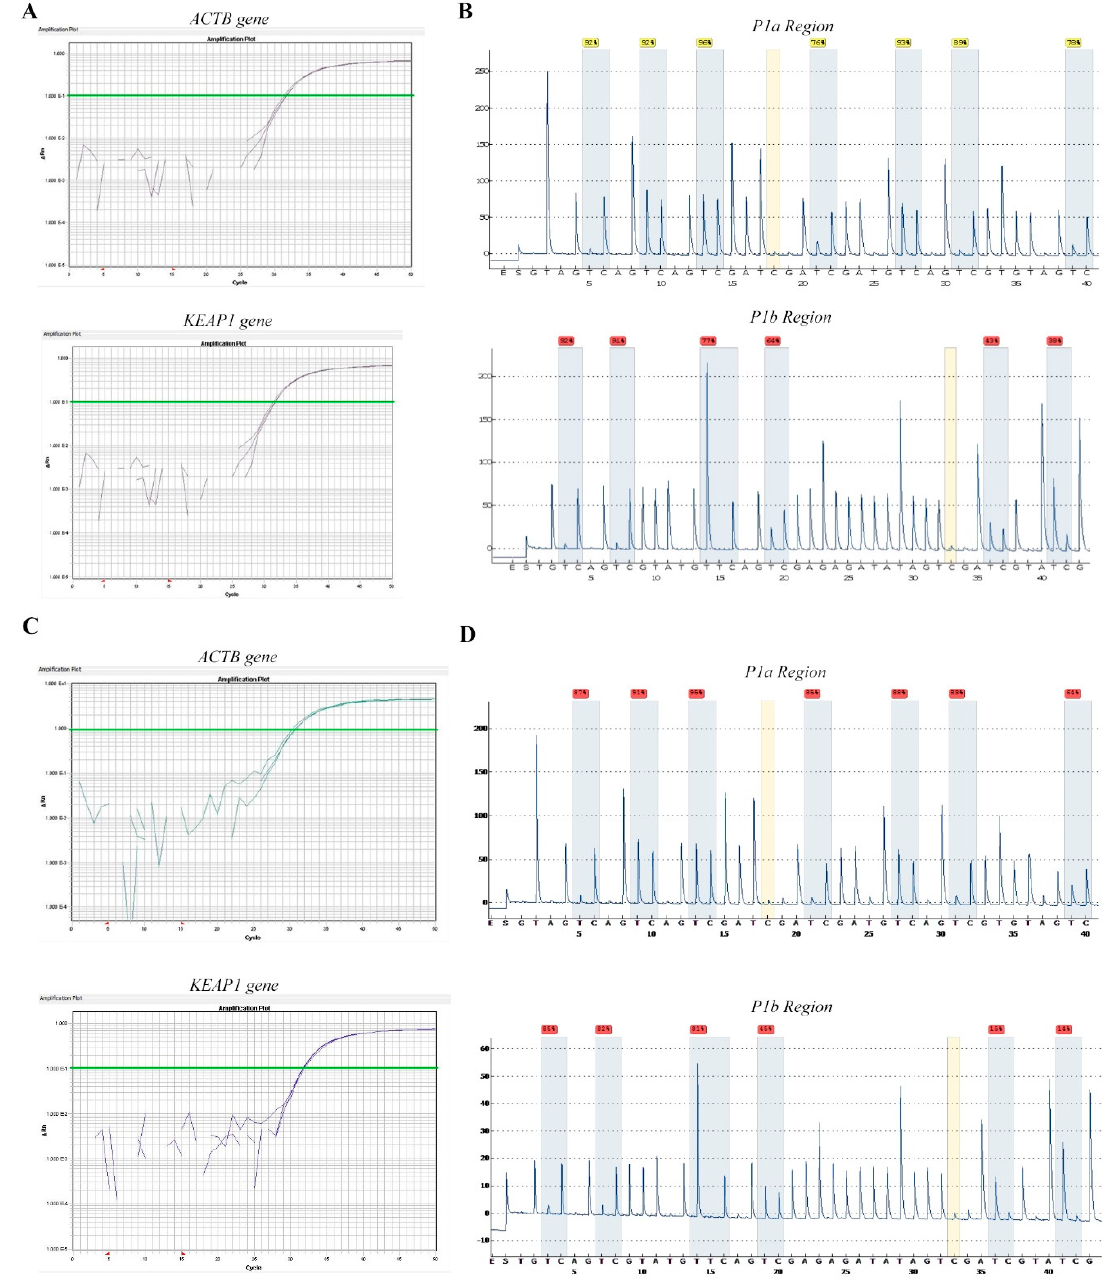
Figure 2. Amplification panels by QMSP and pyrograms of KEAP1 hypermethylated H69V and H1573 cells. Amplification curves (Ct values versus ∆ Rn) of ACTB and KEAP1 genes were reported for ( A ) H69V and ( C ) H1573. Representative KEAP1 promoter pyrograms after DNA bisulfite conversion obtained with the first (P1a region) and second (P1b region) reactions of primers (1–7 and 8–13 CpG sites, respectively) were reported for ( B ) H69V and ( D ) H1573 cell lines. The results from methylation analysis of KEAP1 promoter region by QMSP and pyrosequencing are shown in Table 1. A total of 4 out of 12 SCLC cell lines (34%) were positive for KEAP1 methylation, with mean values of 78.5% (H69V), 27.4% (H209), 39.5% (H1963) and 35.5% (GLC8). H720 carcinoid cells appeared methylated (67.8%), in contrast to the H727, which was under the analytical cut-o ff . In NSCLC cell lines, hypermethylation at the P1 promoter region was found in 4 / 8 (50%) of cell lines: A549, H1573, H1395 (ADC), HCC-15 (SqCC) and H460 (LCC), with the H1573 as the most